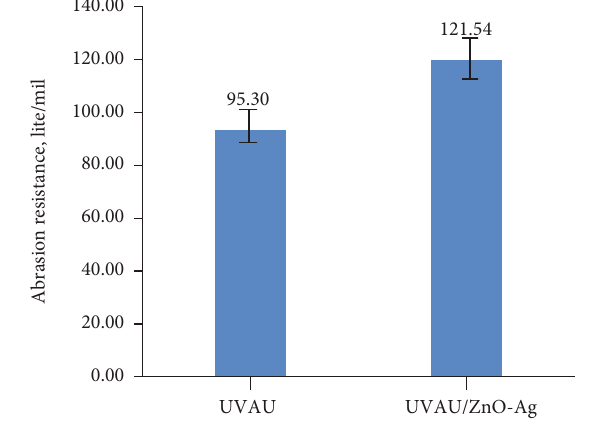
Figure 8: Abrasion resistance of the coating without (UVAU) and with 2wt% ZnO-Ag nanohybrids (UVAU/ZnO-Ag) after 4.8s of curing.